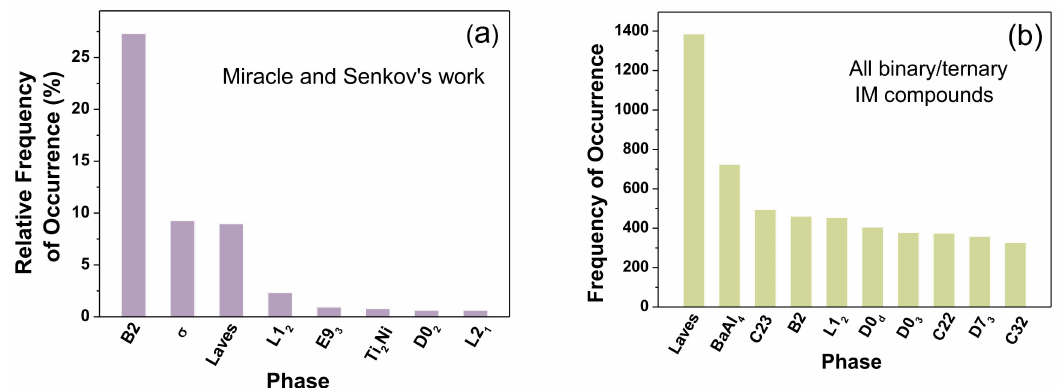
Figure 3. ( a ) Relative frequencies of occurrence for the most common IM structures in Miracle and Senkov’s work, data from [3]; ( b ) Frequency of occurrence for the most common IM structures in all binary/ternary IM phases, data from